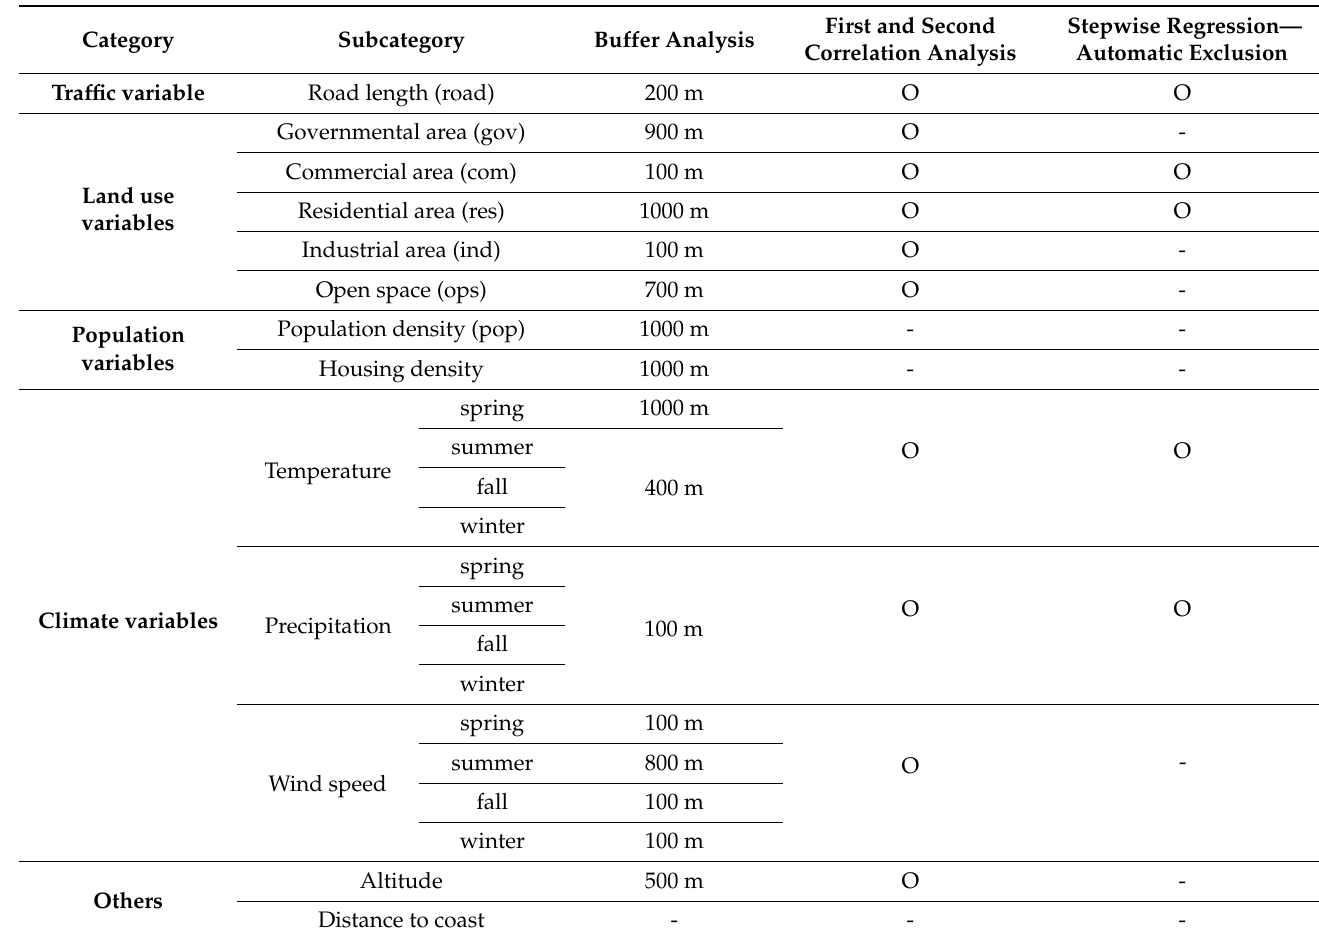
Table 2. Screening process of final variables. The optimum buffer sizes for each variable (subcategory) were selected through buffer analysis. First correlation analysis (between NO 2 concentration and the variables) and second correlation analysis (between the variables themselves) were conducted to screen the decisive variables. Final variables were selected through automatic exclusion and stepwise